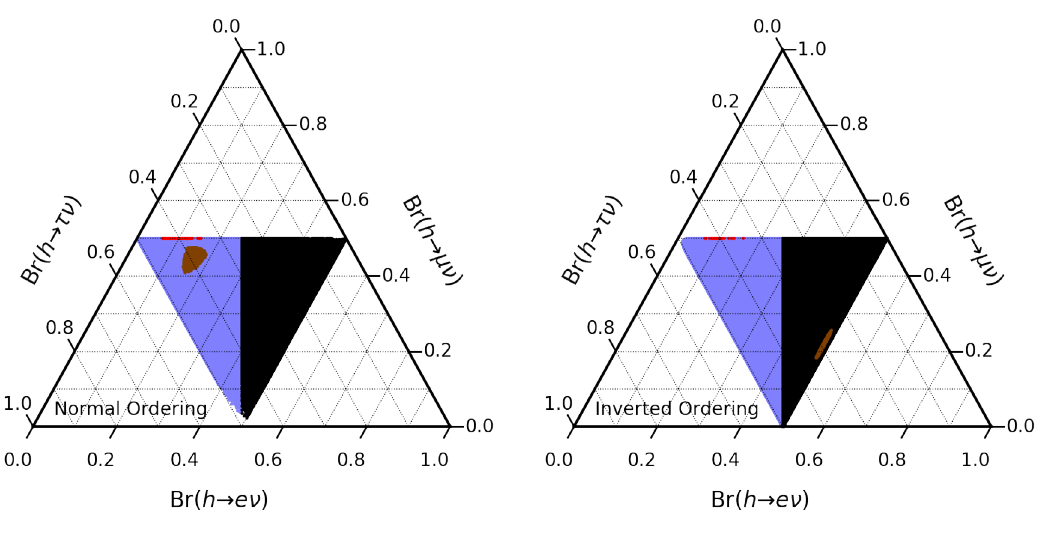
Figure 11 . Branching ratios of h → ‘ν . The colours are the same as in figure 2.